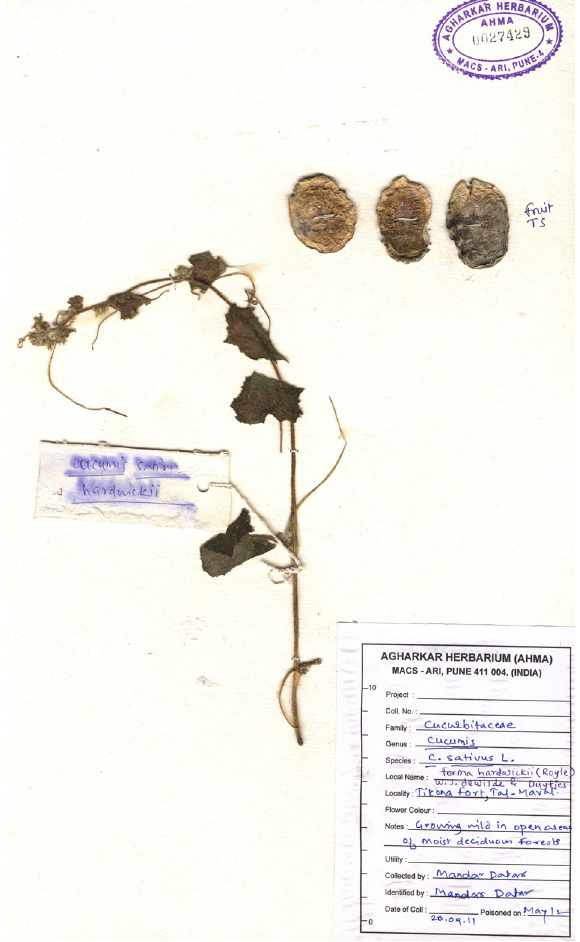
Image 2. Herbarium sheet of Cucumis sativus l. forma hardwickii (Royle) (27429